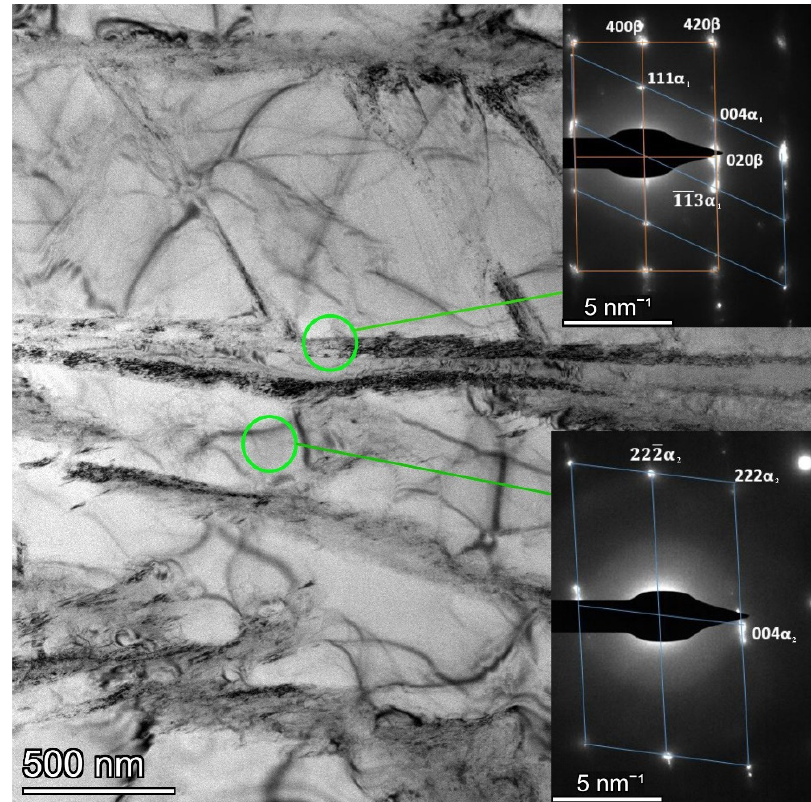
Figure 5. TEM bright field image of the AC sample and the corresponding selected area electron diffraction patterns.